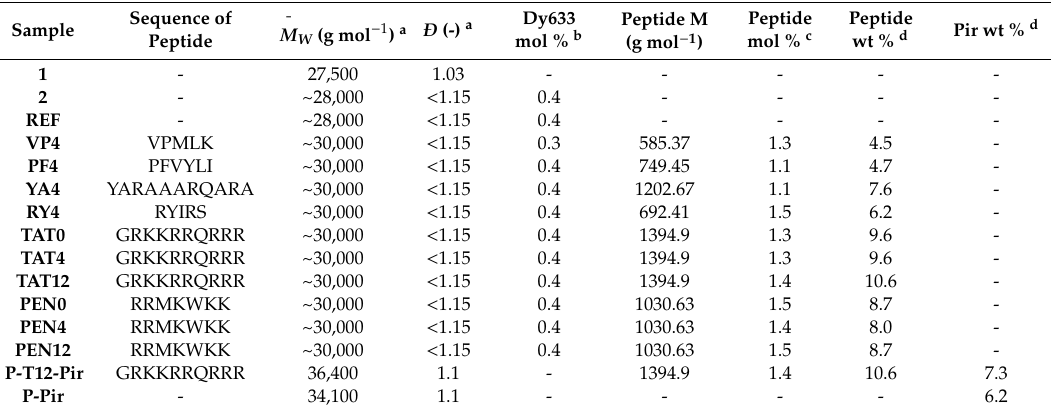
Table 1. Physicochemical characteristics of polymer